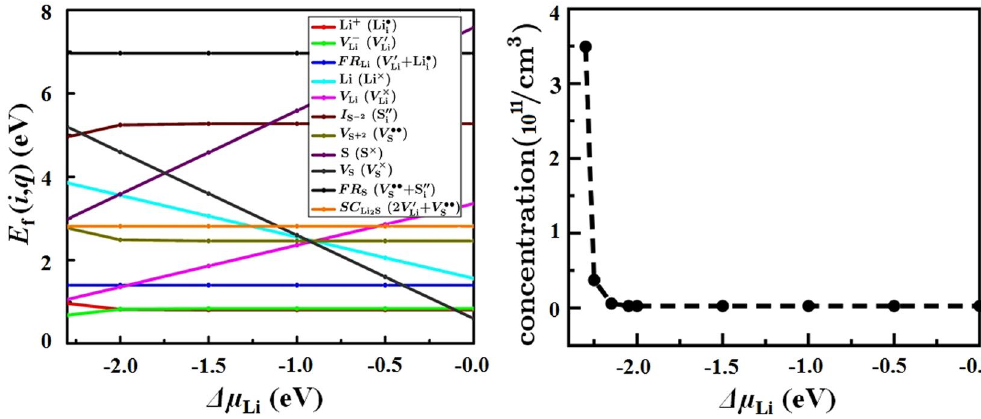
Figure 3. (left) Formation energies of different types of defects in bulk Li 2 S as function of Δ μ Li (chemical potential of Li). Kroger–Vink representations are given in parentheses. (right) Concentration of Li vacancy as function of Δ μ Li